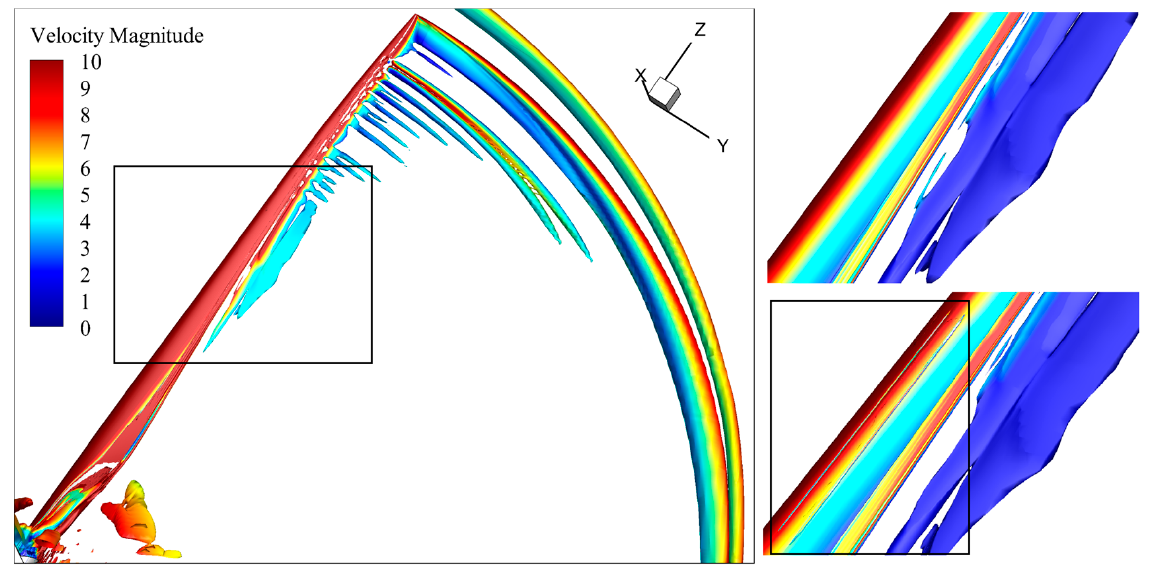
Figure 24. Flow field between the original and the repaired blades. The black box shows the repair area of the spar cap (R = 30–40 m).